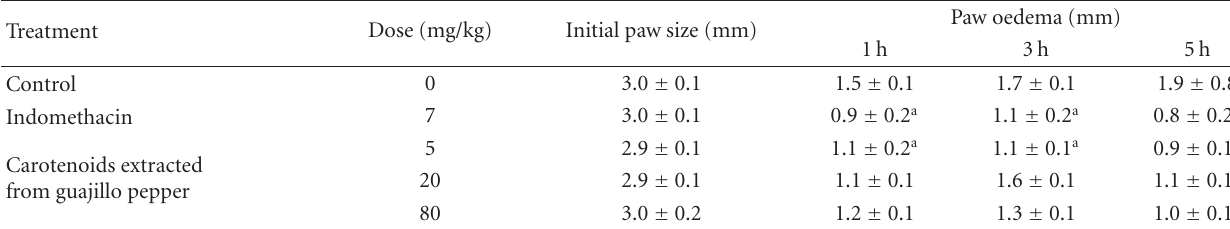
Table 6: The e ff ect of carotenoids extracted from dried guajillo pepper on carrageenan-induced paw oedema.